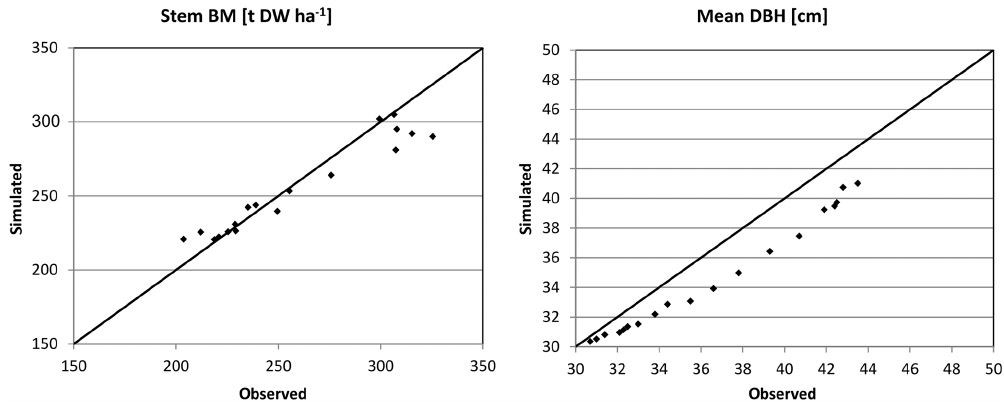
Figure 4. Simulated (sim) vs. observed (obs) DBH and stem biomass (BM) for Solling in the form of scatter plots with a 1 : 1 line.